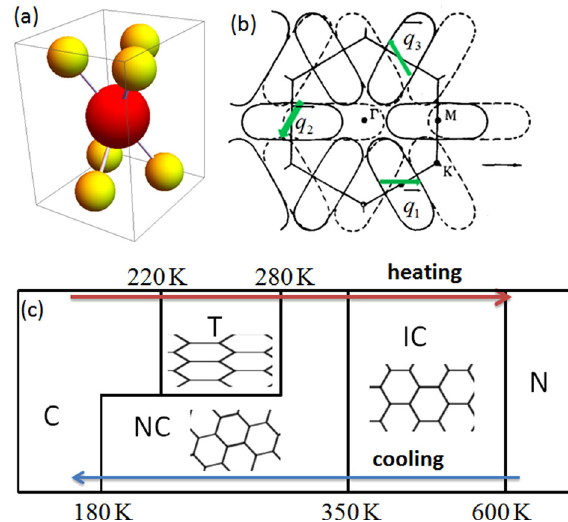
Fig. 1 Properties of 1T-TaS 2 a 1T-polytype structure. The red spheres are tantalum atoms. The yellow spheres are sulfur atoms. b The Fermi surfaces of 1T-TaS 2 . 12 The nesting vector ( green vectors ) are mutually equivalent. The sum of the q vectors is 0 (Triple q ). c CDW states depend on temperature in bulk 1T-TaS 2 . The blue arrow represents the cooling cycle. The red arrow represents the heating cycle. C: Commensurate state, 12 T: Triclinic state 14, 15, 21 which has stretched honeycomb lattices. Between 220 and 280 K the T -satellites are observable but not the NC-satellite or the C-super-lattice re fl ection, even after thermal cycling. NC: Nearly commensurate state, 12 IC: Incommensurate state, 12 N: Normal metal state